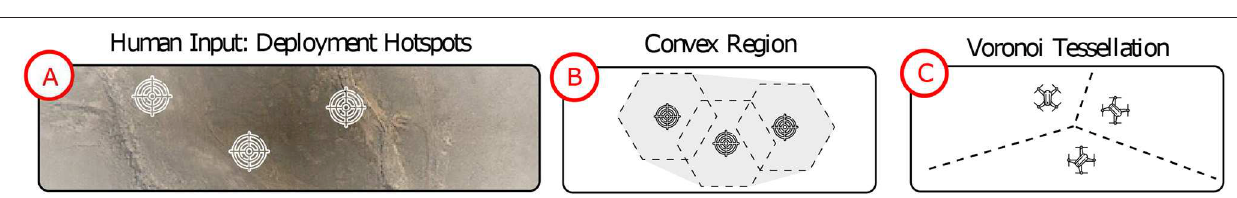
FIGURE 11 | Semi-autonomous fleet deployment algorithm: (A) Operator hotspot inputs, (B) generated convex region from the hotspots list, and (C) the tessellation and gradient descend to uniformly cover the region.